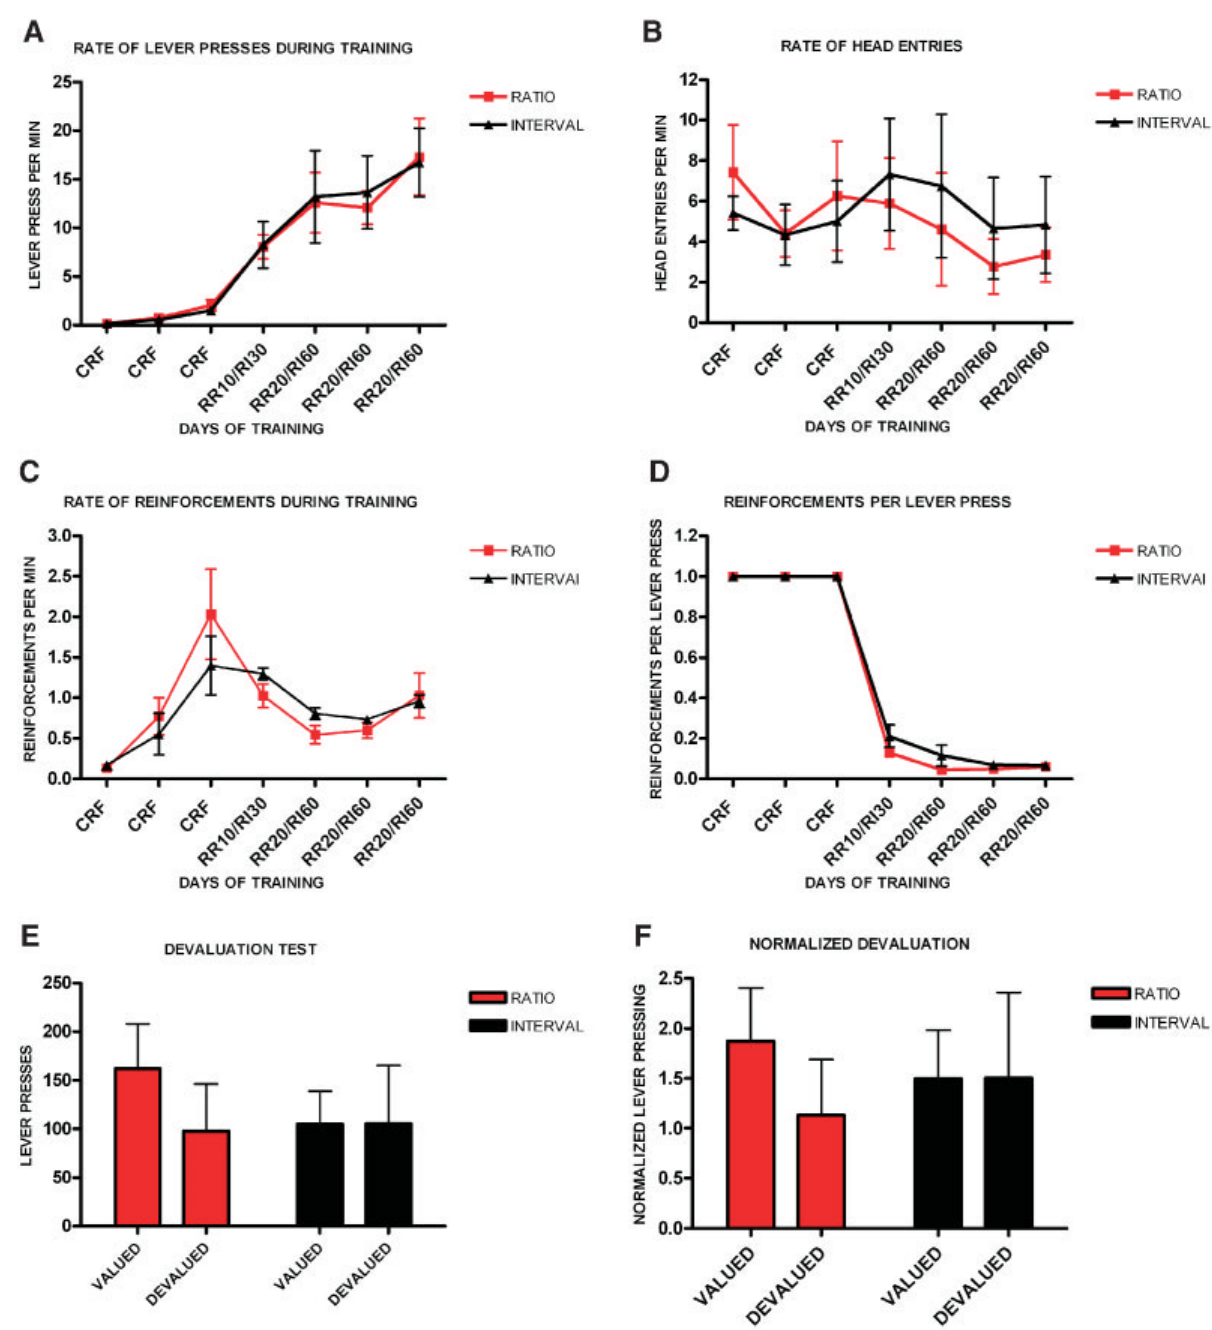
Figure 3. Different schedules of reinforcement induce different sensitivity to devaluation in a subgroup of C57B16/J mice matched for performance during training. (A) Acquisition of the lever-pressing task in animals trained on random ratio and random interval schedules. The rate of lever pressing per minute for each daily session is depicted. (B) Average rate of head entry throughout training for the random interval and random ratio groups. (C) Average rate of reinforcement throughout training for the random interval and random ratio groups. (D) Rate of reinforcement per lever press throughout training for the random interval and random ratio groups. (E) Absolute number of lever pressed during the valued versus the devalued condition for the different training schedules. (F) Lever pressing during the valued versus the devalued condition normalized to the lever pressing of the last day of training.